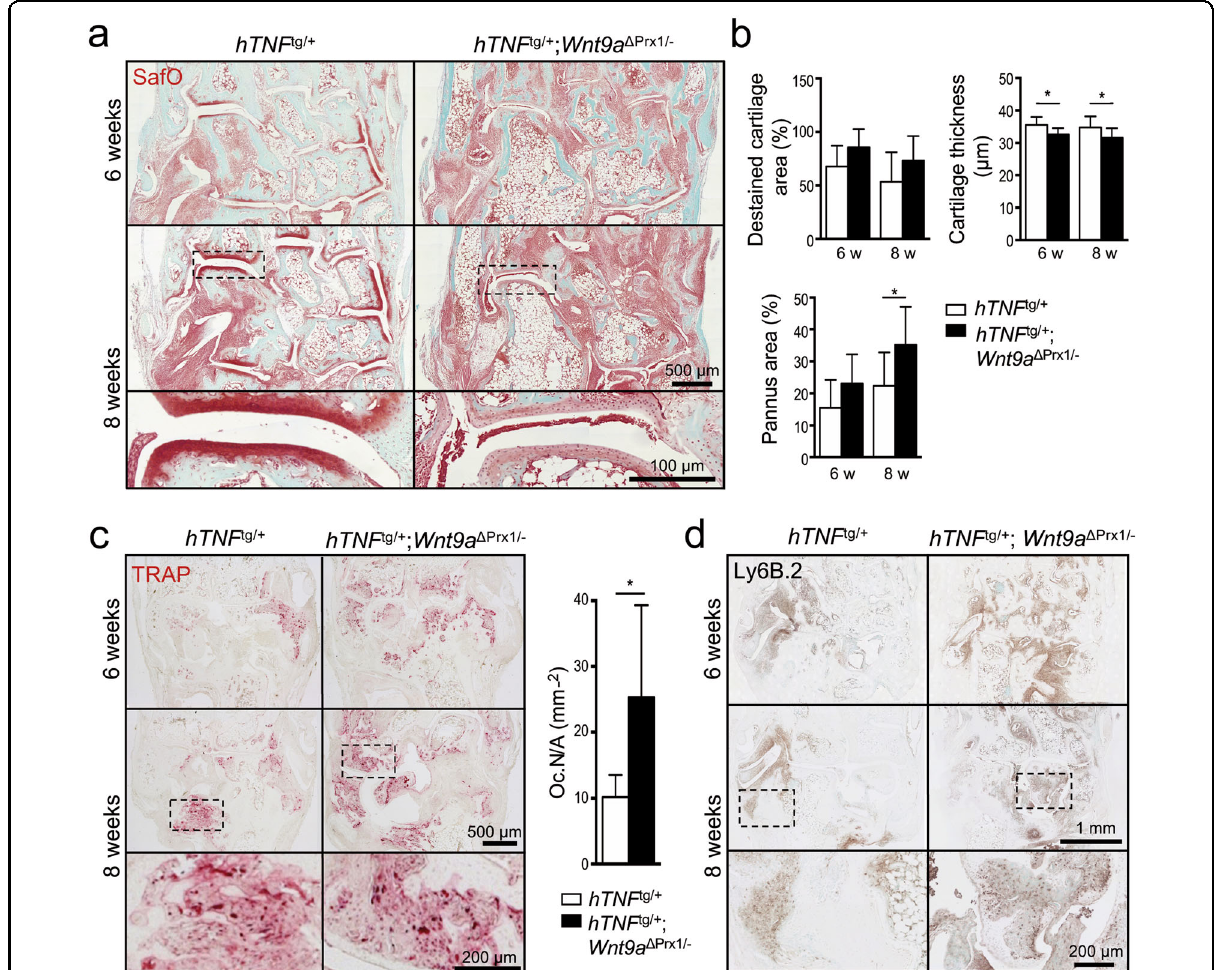
Fig. 3 Wnt9a -de fi ciency promotes pannus formation and joint destruction in hTNF transgenic mice. a Representative images of Safranin O stained tarsal joint sections from 6- and 8-week-old hTNF tg/ + and hTNF tg/ + ; Wnt9a Δ Prx/ − , showing increased pannus formation in the hTNF tg/ + ; Wnt9a Δ Prx/ − hind paw regions ( n = 9). b Quantitative histomorphometric analysis of destaining of cartilage, cartilage thickness, and pannus area in 6- and 8-week-old hTNF tg/ + and hTNF tg/ + ; Wnt9a Δ Prx/ − hind paws ( n = 9). c Representative images of tartrate-resistant acid phosphatase (TRAP) staining (red color) of tarsal joint sections from 6- and 8-week-old hTNF tg/ + and hTNF tg/ + ; Wnt9a Δ Prx/ − mice ( n ≥ 4). Quanti fi cation of TRAP-positive osteoclasts on sections of 8-week-old hTNF tg/ + ( n = 7) and hTNF tg/ + ; Wnt9a Δ Prx/ − ( n = 4) within the tarsal region (as in a ). d Representative images of immunohistochemically stained sections of 6- and 8-week-old hTNF tg/ + and hTNF tg/ + ; Wnt9a Δ Prx/ − hind paws, showing the increased presence of Ly6B.2 + neutrophils in the Wnt9a -de fi cient background ( n = 9). Data in b and c are presented as mean ± SD, P -values: